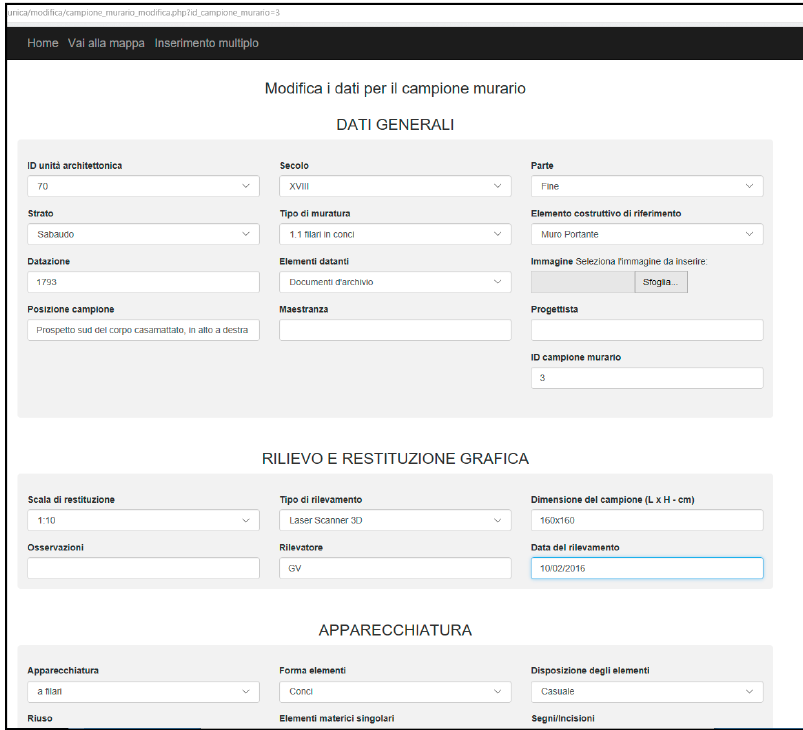
Figure 4. The Example of the Masonry Sample Input Form (S. Ignazio Fort).